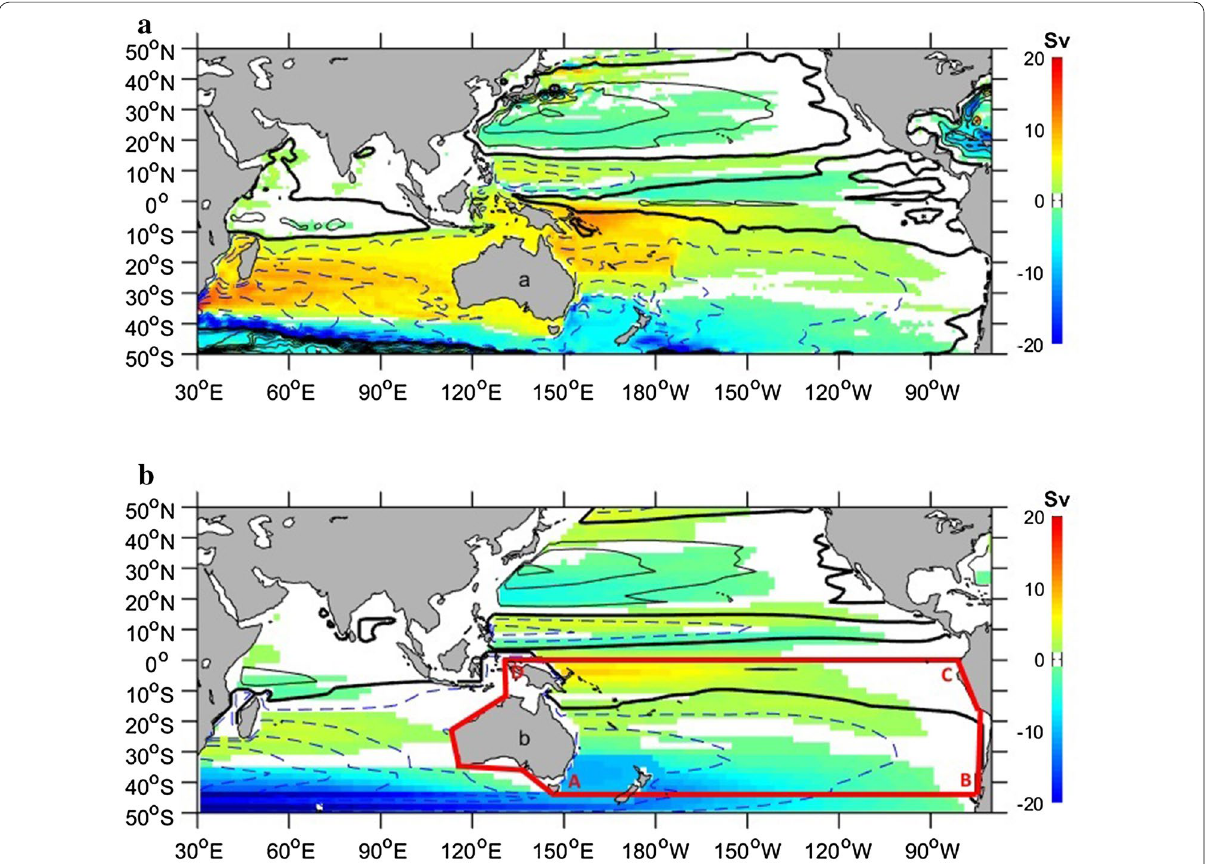
Fig. 3 Mean and linear changes of barotropic stream function from model and the Island Rule. a Mean (contour) and linear changes (shading) of barotropic stream functions in the Indo-Pacific Ocean during 2006–2101 from the OFAM3 RCP8.5 run; b mean (contour) and linear changes (shading) in stream functions during 2006–2101 derived from the Sverdrup Balance and Island Rule; The mean stream functions in ( a ) and ( b ) are from the OFAM3 historical run during 1979–2014 and their linear changes are derived from the RCP8.5 run. The contour interval for the mean stream functions is 10Sv, with heavy black contours denoting the zero stream functions and blue dashed contours denoting negative values. Linear changes of less than 1Sv are not shown. In ( b ), the red lines delineate the integration route for the wind stress in the Island Rule calculation. (Repro- duced with permission from (Feng et al.